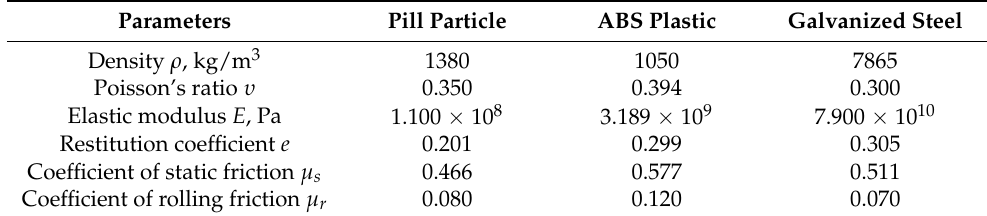
Table 1. Parameter selection for